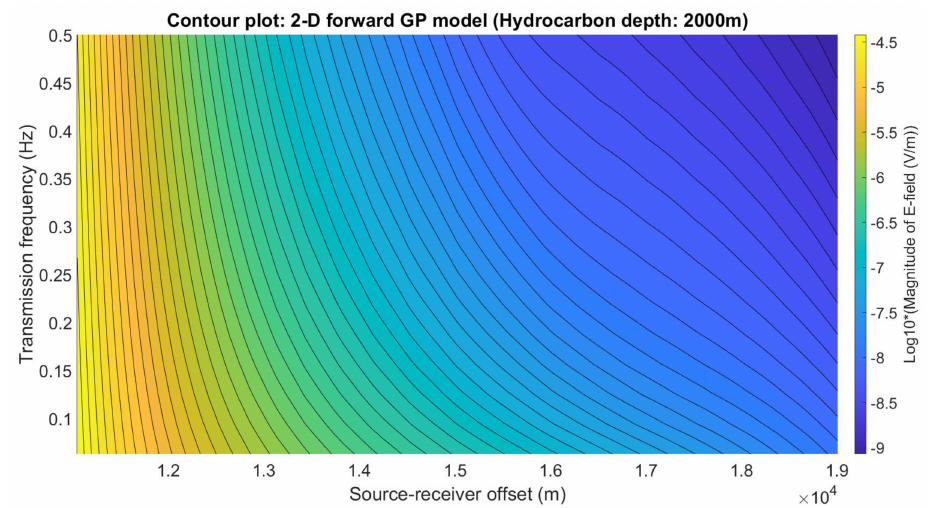
Figure 7. Contour plot of the 2D forward GP model. EM responses versus source-receiver separation distance for all tried and untried transmission frequencies (0.0625–0.5 Hz) at overburden thickness of 2000